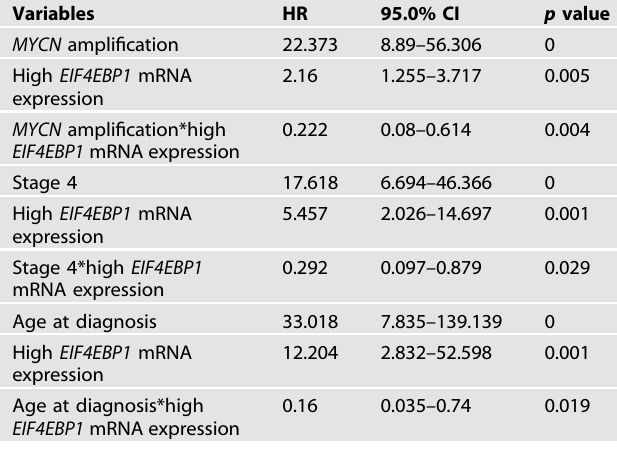
Table 1. Multivariate analysis for overall survival of NB patients in the SEQC cohort.